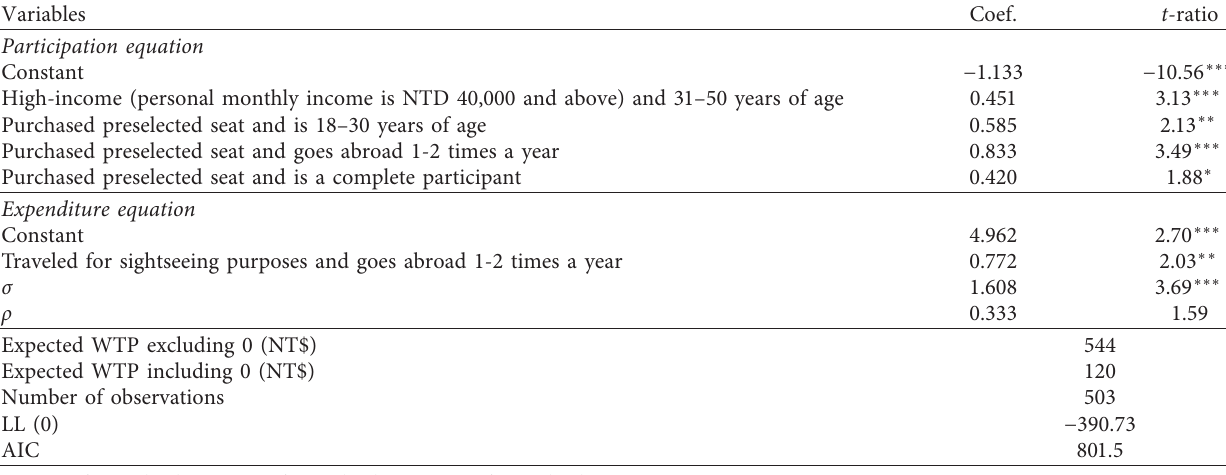
Table 10: Estimated result of the model for seat preselection (extra legroom seat).